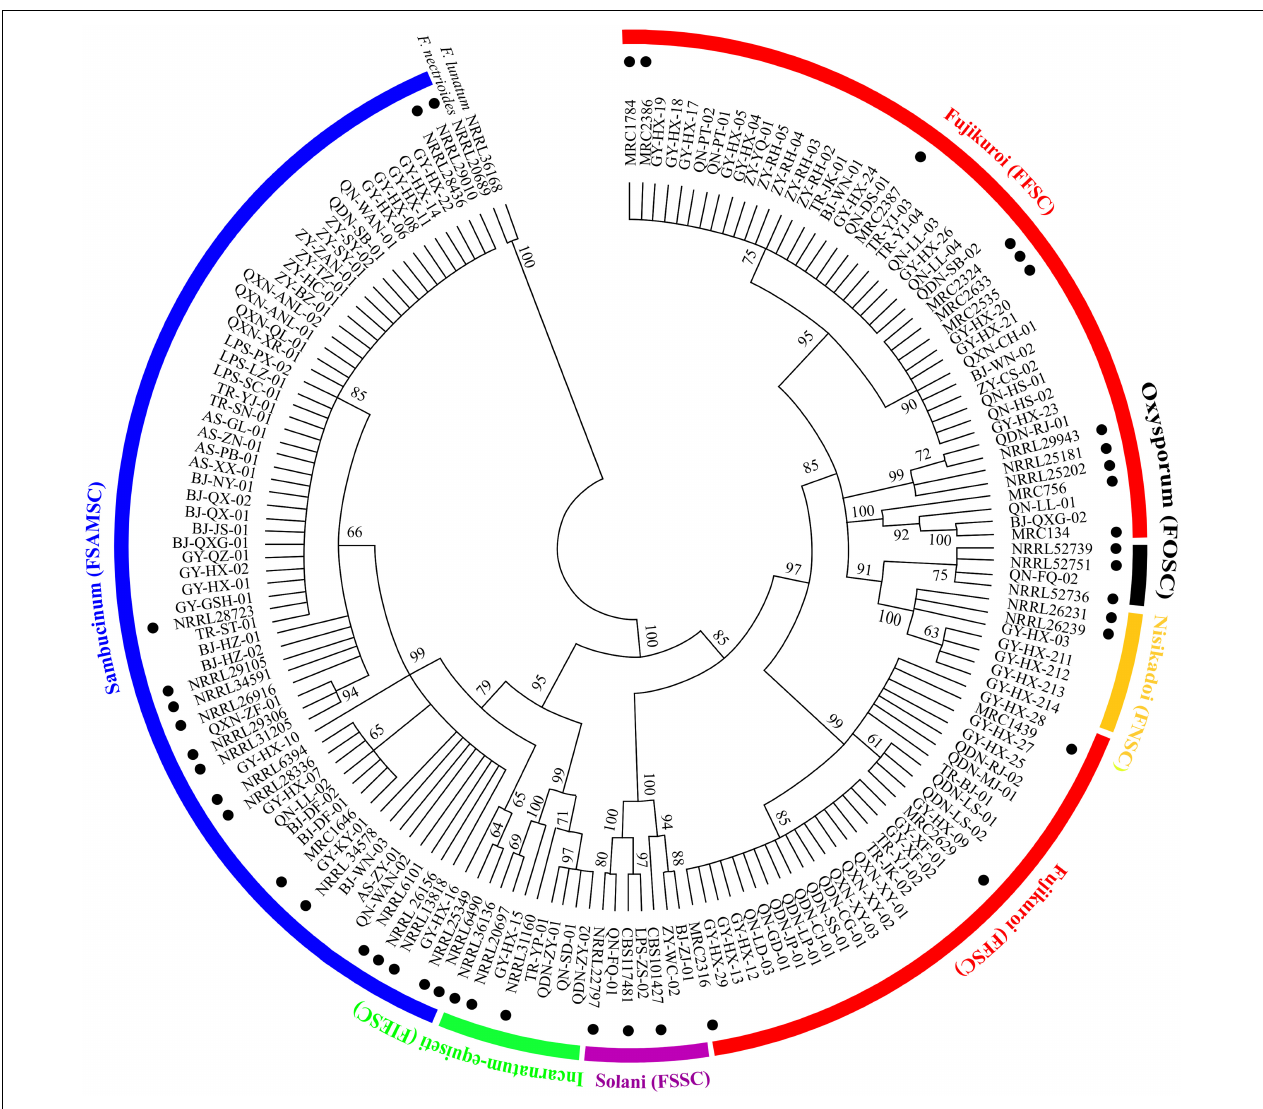
FIGURE 4 | Phylogenetic tree of 123 Fusarium isolates based on the TEF-1 α gene. Bootstrap values ( ≥ 60%) of a bootstrap test of 1,000 replicates are shown on branching nodes. Reference TEF-1 α sequences of the NRRL/MRC/CBS strains were downloaded from the FUSARIUM-ID database and GenBank database. Sequences of Fusarium nectrioides and Fusarium lunatum were used as outgroups.